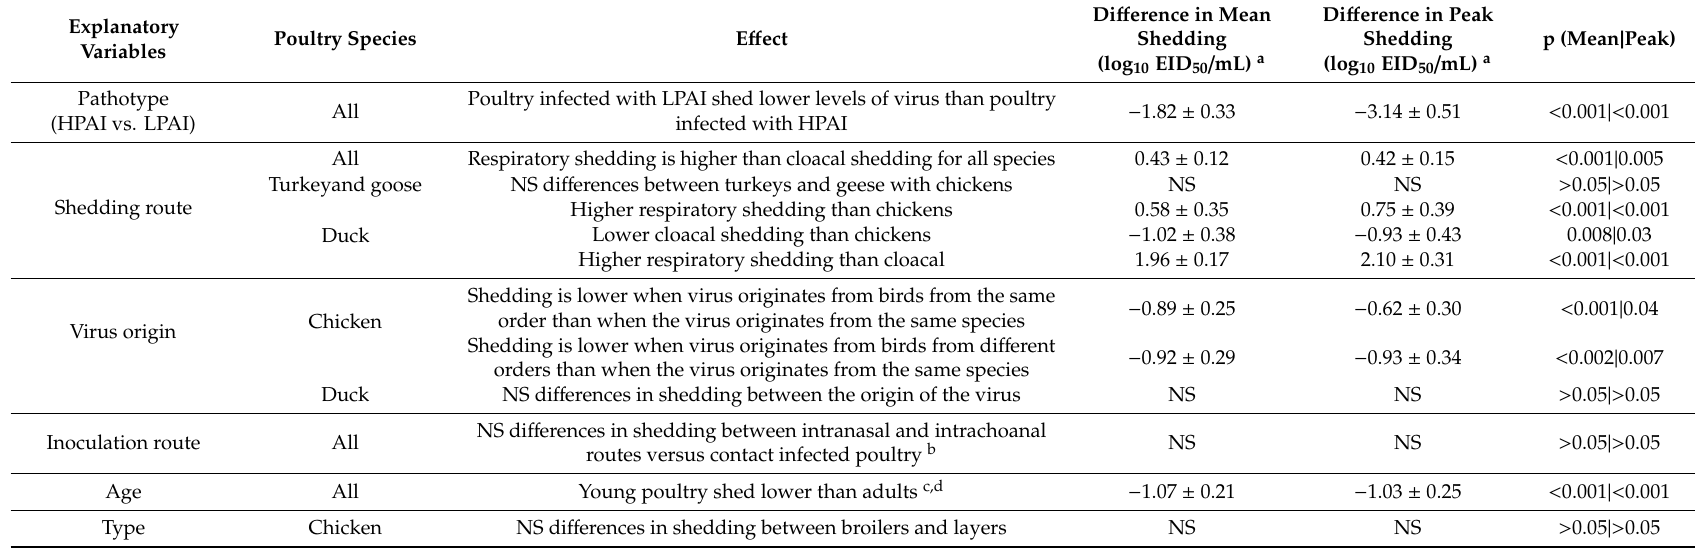
Table 2. Variables a ff ecting shedding (assessed as geometric mean shedding and peak shedding) level in chicken, duck, turkey and goose infected with HPAIV. Explanatory